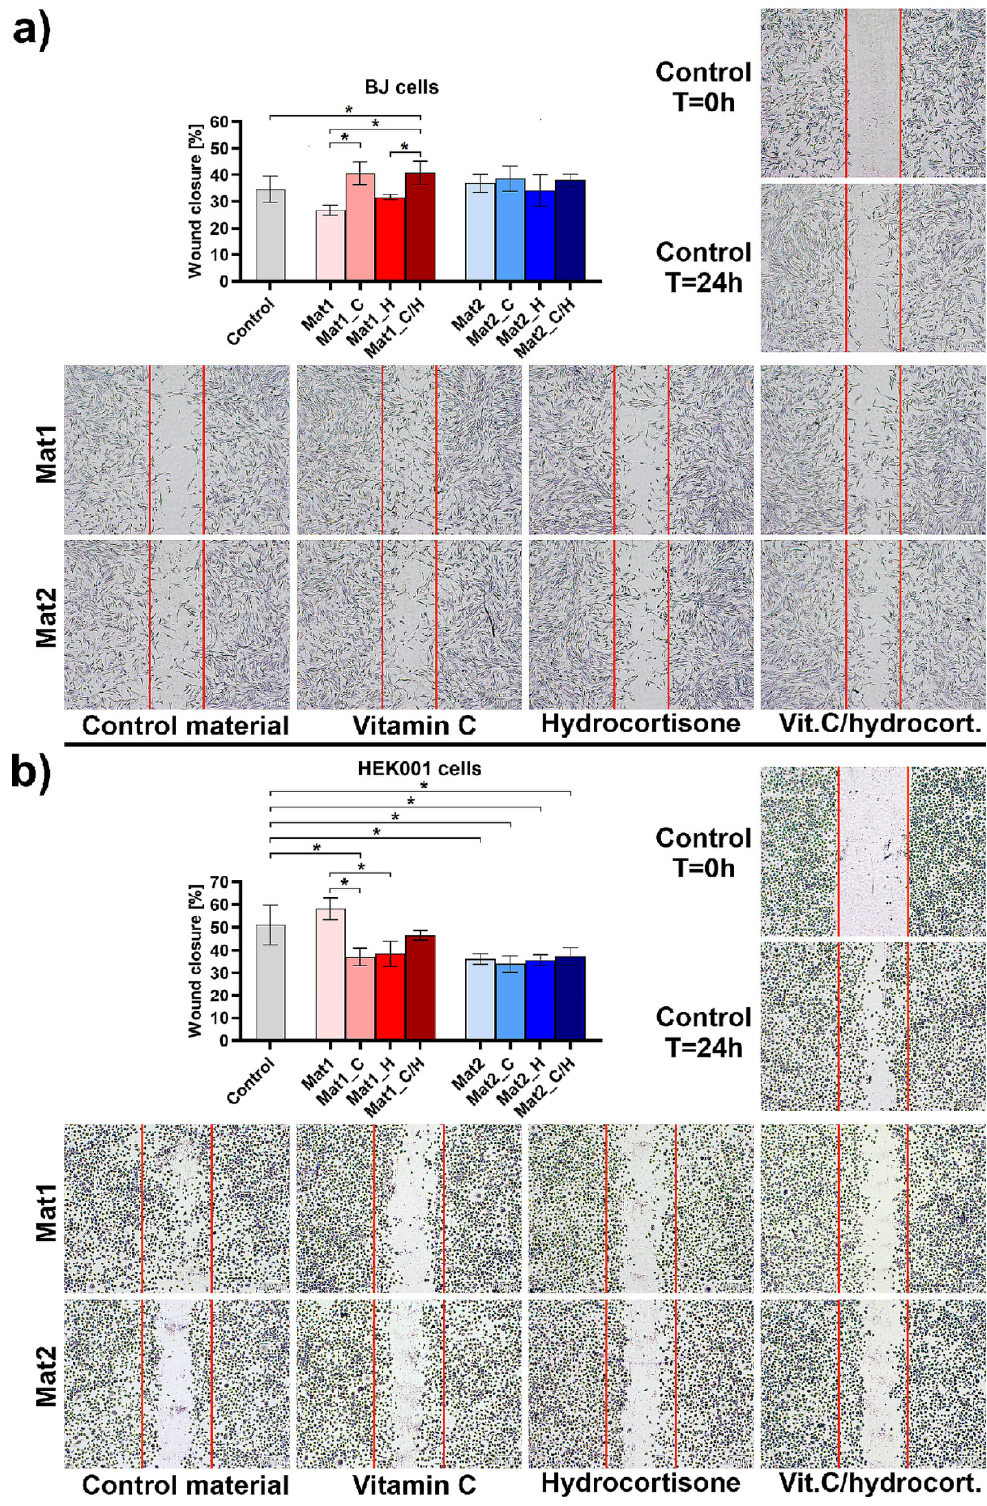
Figure 3. Cell migration after exposure to the extracts of biomaterials: ( a ) migration of human skin fibroblasts (BJ cell line) and ( b ) migration of human epidermal keratinocytes (HEK001 cell line) (control–cells maintained in the presence of polystyrene extract); * statistically significant results between indicated groups, n = 3, p < 0.05, one-way ANOVA followed by Tukey’s test (Mat1: curdlan/agarose biomaterial, Mat2: curdlan/chitosan biomaterial, C–vitamin C, H–hydrocortisone, C/H–mixture of vitamin C and hydrocortisone, T = 0 h–wound surface just after scratching, T = 24 h–wound surface 24 h after scratching).